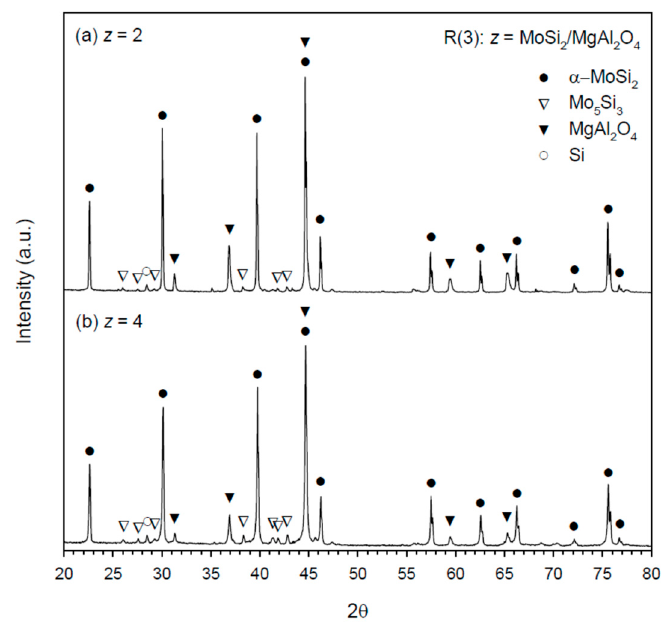
Figure 7. XRD patterns of as-synthesized MoSi 2 –MgAl 2 O 4 composites from R(3) with ( a ) z = 2 and ( b ) z = 4.